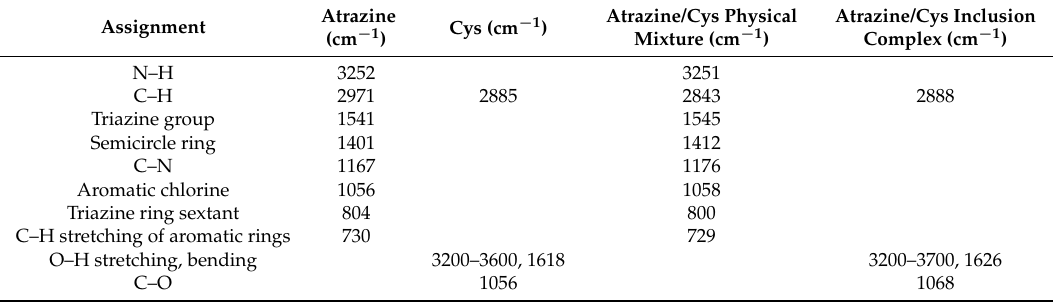
Figure 4. Fourier transform infrared (FT-IR) spectra of ( a ) atrazine; ( b ) Cys; ( c ) atrazine/Cys physical mixture; and ( d ) atrazine/Cys inclusion complex. Table 1. FT-IR absorption bands for atrazine, Cys, atrazine/Cys physical mixture, and atrazine/Cys inclusion